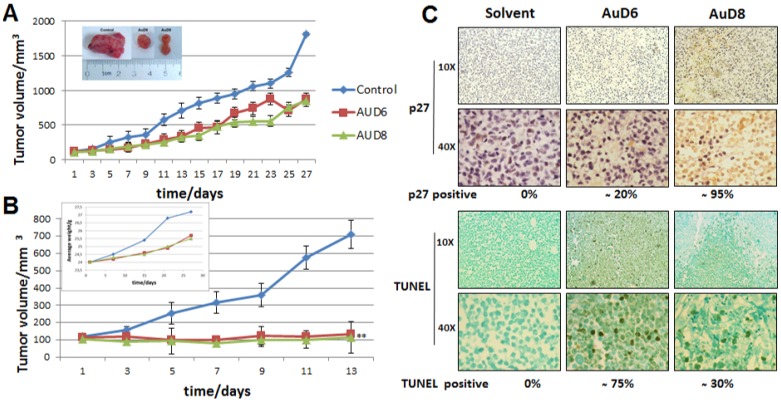
Antitumor activity in vivo on MDA-MB-231 xenografts.Female nude mice bearing MDA-MB-231 tumors were treated with either vehicle (control) or the compounds AuD6 and AuD8 at 1 mg kg−1 d−1. A, Inhibition of xenograft growth by both complexes. Tumor volumes were measured every other day using a caliper. Points represent the mean ± SD (bars) of seven mice per group. The insert depicts representative tumors from each treatment group; * = p<0.05. B, If only the most responsive mice are considered, the xenograft growth inhibition is greater. The insert shows average weights of mice over time; ** = p<0.01. C, Immunohistochemical p27 and TUNEL staining of tumor samples indicates proteasome inhibition and apoptosis as a result of both compounds. Stronger p27 staining is observed following AuD8 treatment, and more TUNEL positive cells are observed following AuD6 treatment. Brown colored cells are considered positive.